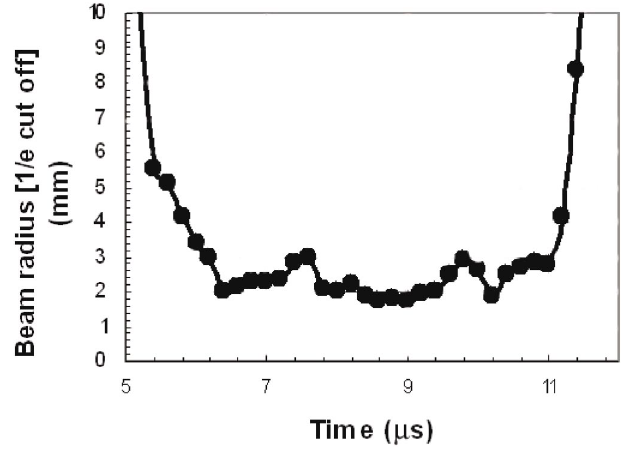
FIG. 12. Spot size variation from head to tail measured at the focal plane, showing blow up of the beam head and